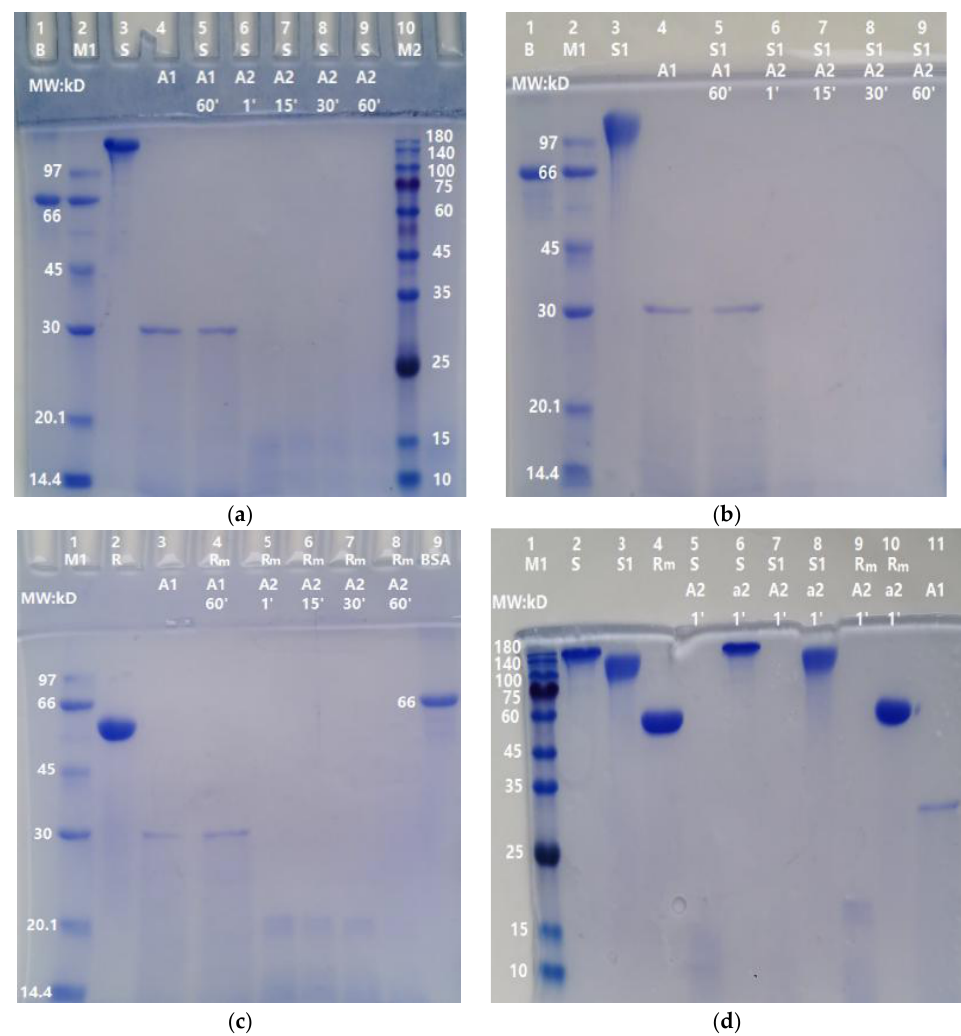
Figure 3. Degradation of S, S1, and Rm by ASPNJ for different incubation times: ( a ) degradation of S; ( b ) degradation of S1; ( c ) degradation of RBD-mouseFc (Rm); and ( d ) degradation of S, S1 and Rm by ASPNJ for 1 min. The concentrations of S, S1, and Rm were all 10 µ g/lane. A1 and A2 were ASPNJ of different concentrations (A1–A2 was 30, 1 µ g/lane). B: BSA. The three proteins were degraded with ASPNJ with a total volume of 25 µ L, and degraded at 40 ◦ C for 1, 15, and 30 to 60 min, respectively. The degradation effect was observed by running SDS-PAGE. The lowercase letter a in ( d ) represents the denatured ASPNJ, which was heated at 80 ◦ C for 5 min. Both of A2 and a2 were 1 µ